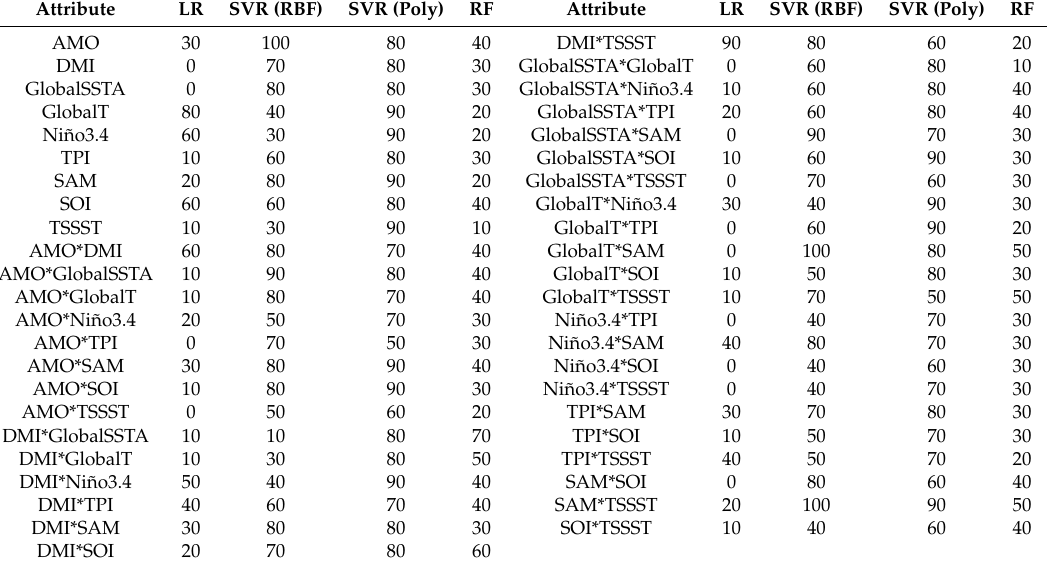
Table 1. Percentage of folds selecting attributes for precipitation in linear regression (LR); support vector regression (SVR) with the radial basis (RBF) and polynomial (Poly) kernel functions; and random forests